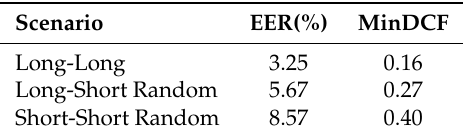
Table 1. Results, EER (%) and minDCF of SRE10 “coreext-coreext det5 female” experiment with the three scenarios of interest: Long-Long, Long-Short and